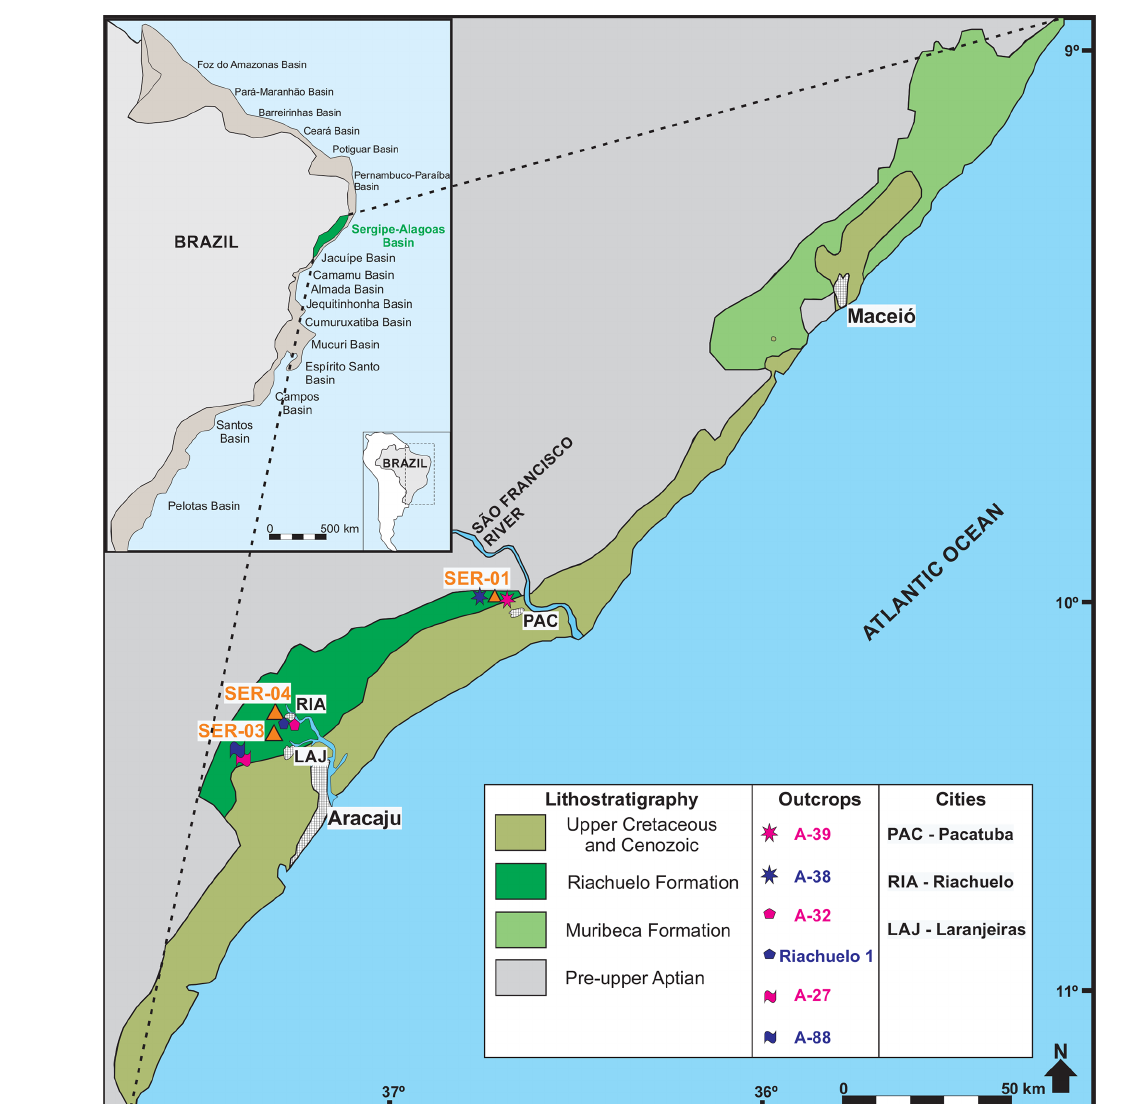
Figure 2. Sketch map of eastern Brazil with the lithostratigraphy of the Sergipe–Alagoas Basin (modified of Bengtson, 1983), locations of boreholes (SER-01, SER-03, and SER-04), key outcrops near the cores (see Table 1), and major